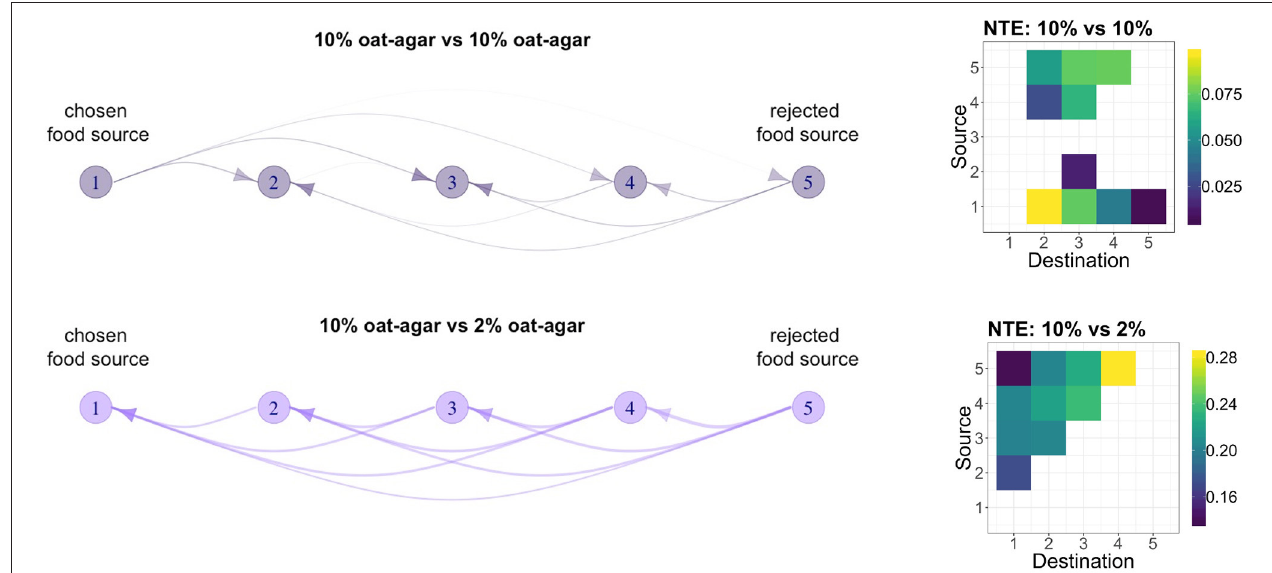
FIGURE 5 | Networks and their adjacency matrix of information flow between groups of adjacent locations (i.e., 1 = { 1, 2, ..., 10 } , ..., 5 = { 41, 42, ..., 50 } ) on the P. polycephalum tubule constructed from net transfer entropy averaged over all experimental trials. The orientation of the tubule in each trial is adjusted so that the final choice of the tubule is always on the left side of the network (i.e., vertex 1); edge width is proportional to the net transfer entropy. Parameters: 10 vs. 10% w/v ( k = 3, smoothing span 0.001), 10 vs. 2% w/v ( k = 10, smoothing span